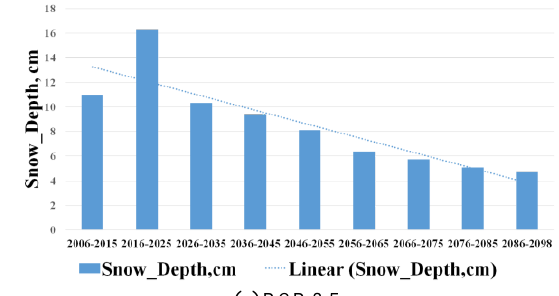
Figure 7. Trend of each water balance components under each climatic scenario As the temperature is showing increasing trend in both the scenarios, it is definitely going to affect the snow cover, snow depth, snow melt and snow water equivalent. Therefore, trend of each of these parameters has also been studied are shown in Figure